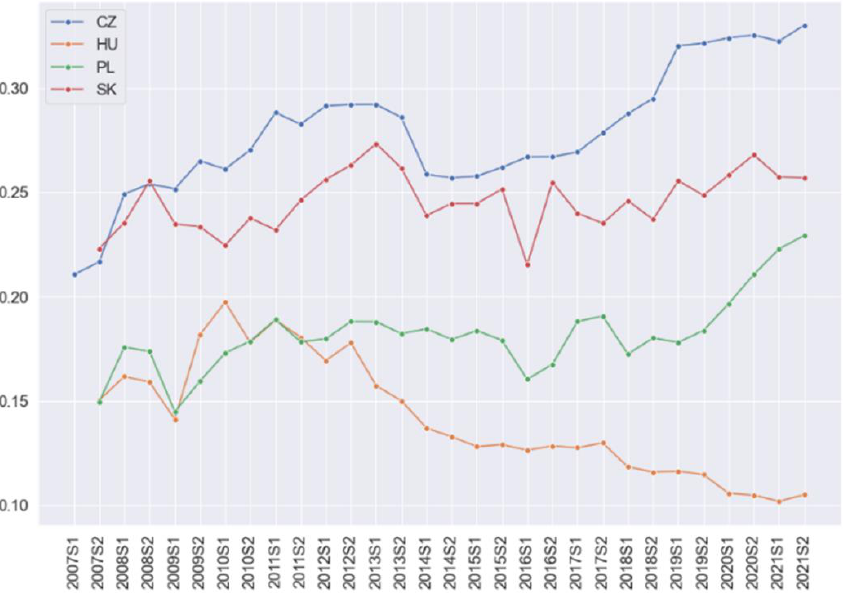
Figure 6. Non-household electricity prices including taxes and levies in the lowest consumption band in selected countries. Source dataset: Eurostat: NRG_IND_REN.